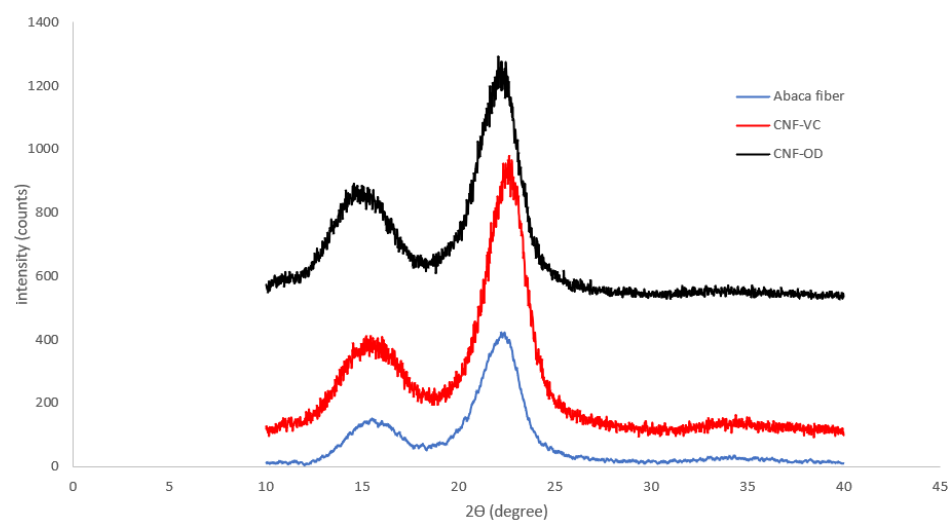
Figure 6. XRD scans of cellulose materials.